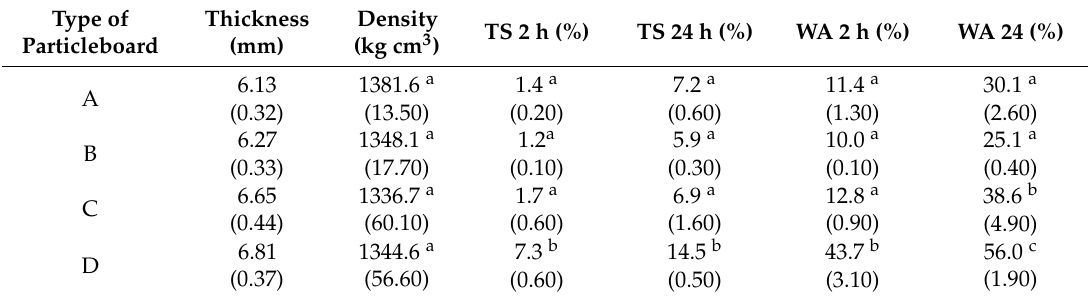
Table 4. Physical properties 365 days after the manufacture of the